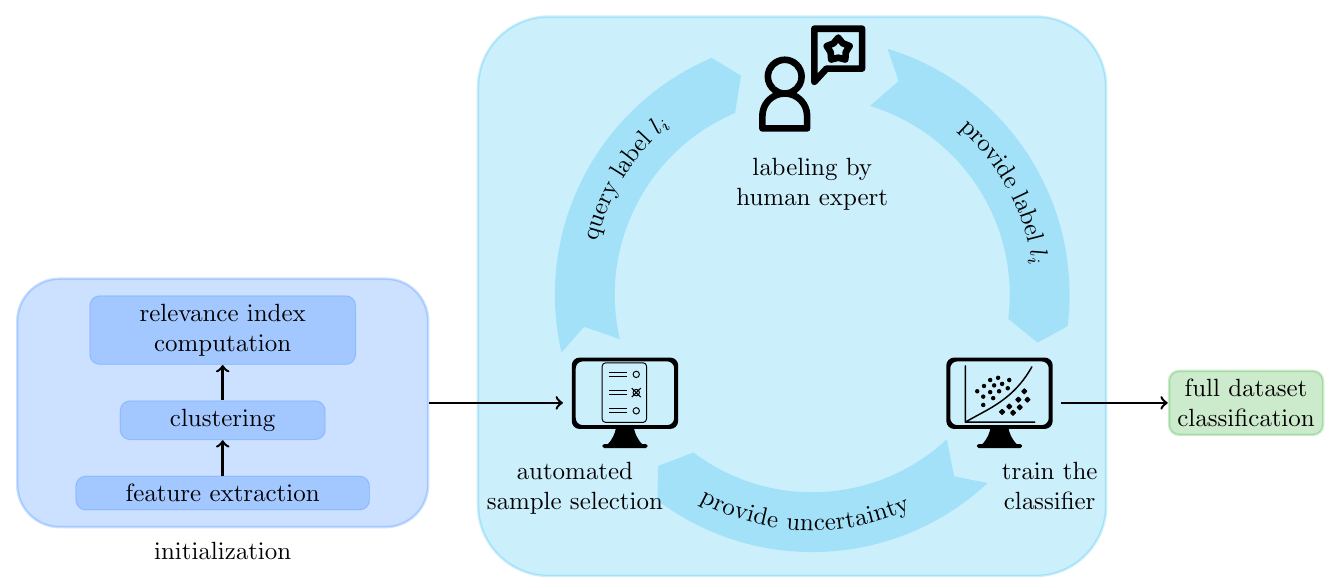
Figure 3. Overview of the active learning method. In preparation for the selection of the training samples, the samples are clustered, and a relevance index is assigned to each cluster. Furthermore, a feature vector is extracted for every image. For the selection of the training images, three consecutive steps are repeated iteratively: (i) A training sample is chosen from the set of images according to the sampling strategy and the state of the classifier. (ii) The sample is labeled by an expert. (iii) The classifier is updated. The trained classifier can then be used to classify the remaining